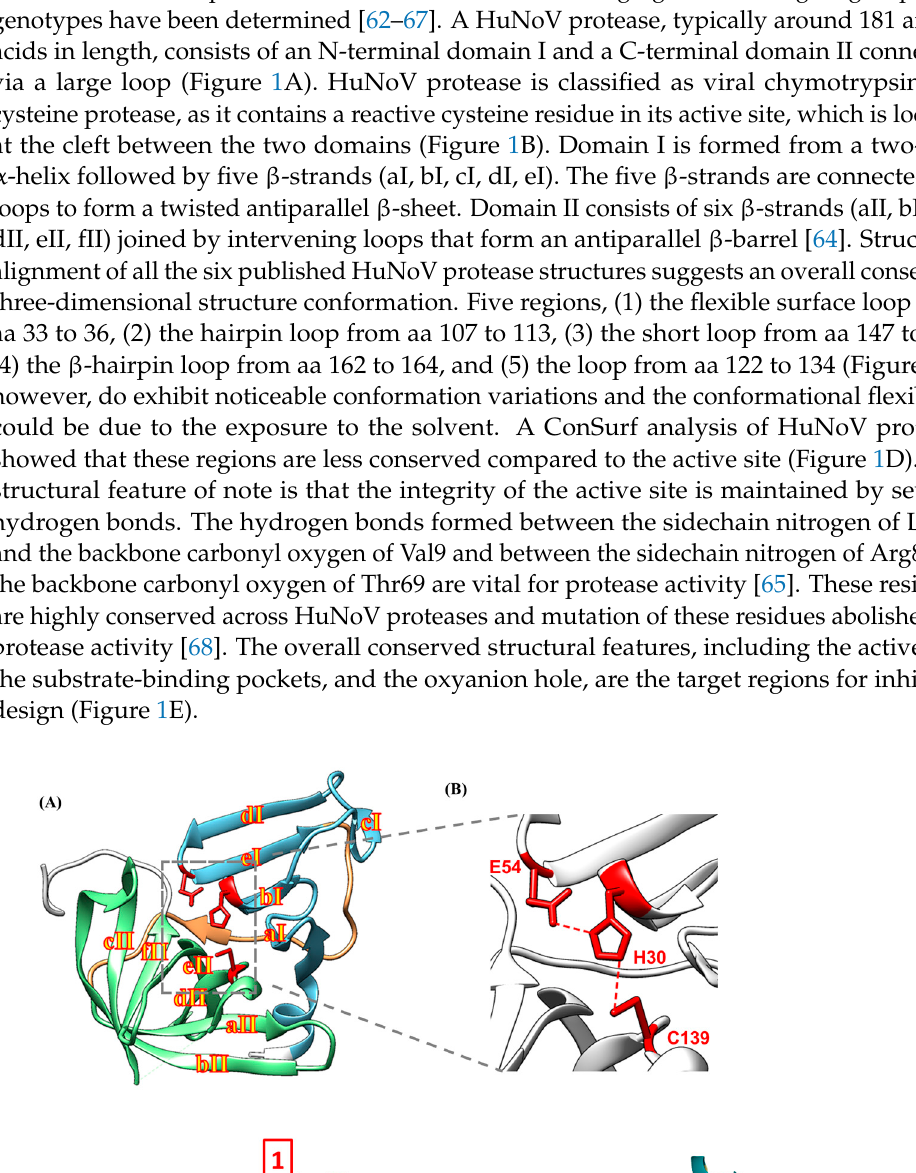
Figure 1. Three-dimensional structure of HuNoV protease and its active site. ( A ) Ribbon represen- tation of Norwalk protease structure (PDB ID: 2FYQ). Domain I (cyan) is connected to Domain II (lime) via a large loop (orange). The catalytic residues are shown as red stick models. The β -strands are shown as yellow characters with red outline. ( B ) The active site of HuNoV protease contains three residues colored red. ( C ) Structures of all the published protease are overall conserved with several regions exhibiting conformation flexibility, indicated by the red arrows. The five regions are: (1) the flexible surface loop from aa 33 to 36, (2) the hairpin loop from aa 107 to 113, (3) the short loop from aa 147 to 150, (4) the β -hairpin loop from aa 162 to 164, and (5) the loop from aa 122 to 134 ( D ) Conservation of amino acid positions in HuNoV protease structures. The figure was generated with the ConSurf server [69]. ( E ) The amino acid residues are colored in red for the active site, blue for the oxyanion hole, green for the S1 pocket, cyan for the S2 pocket, and magenta for the S4 pocket.